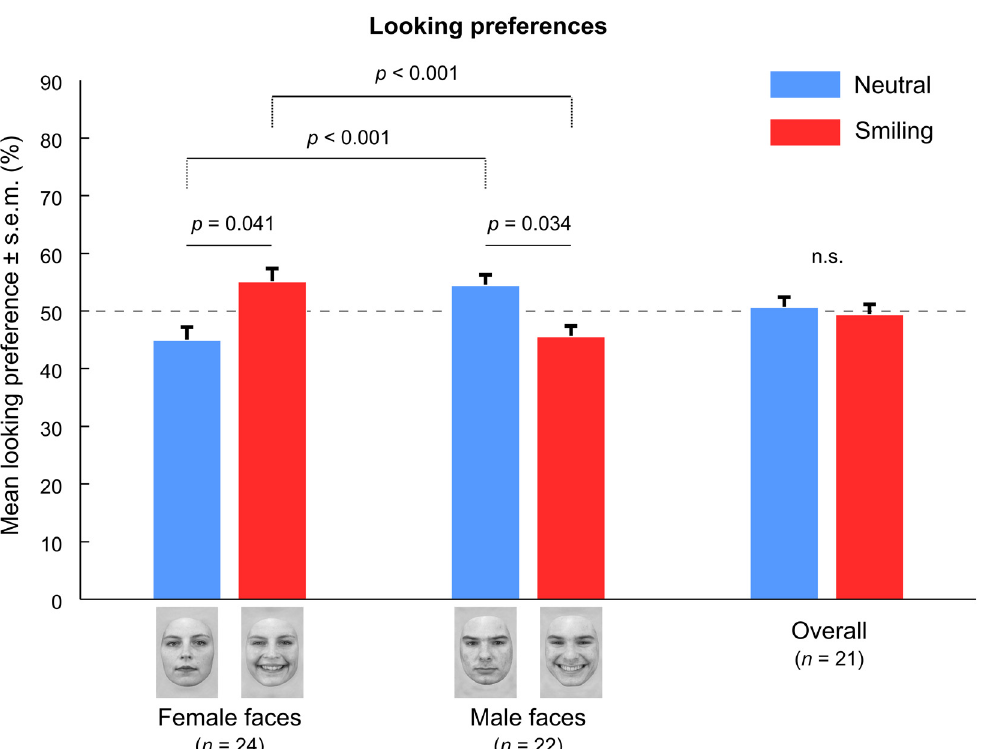
Fig 2. Face gender influences the looking preference for smile. A looking preference of 50% represents chance level. Overall, infants preferred looking to the smiling face in female pairings, and to the neutral face in male pairings (as measured by Percentages of Total Looking Time, PTLT). There was no overall preference when pooling female and male trials together. Paired Student t -tests, α = 0.05, uncorrected.